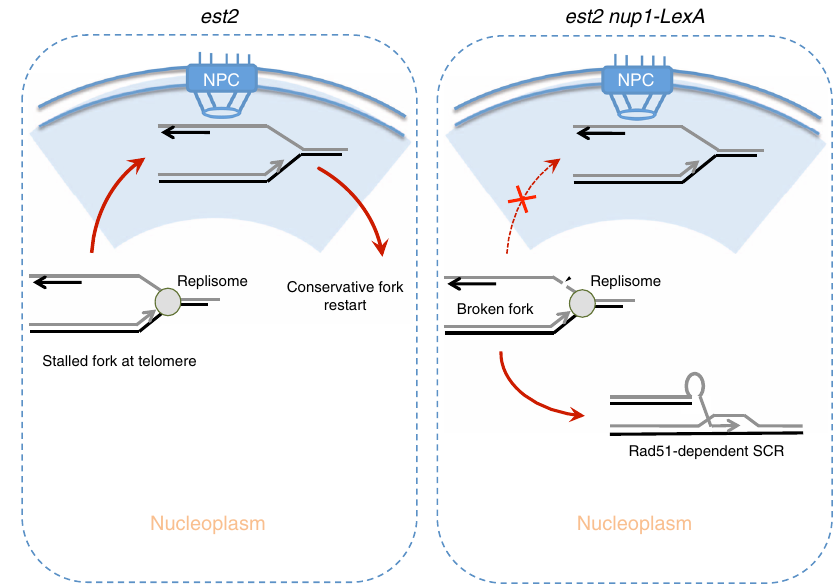
Fig. 8 Model for the role of the NPC in the repair of fork stalled at telomeres. Replication forks stalled at telomeres relocalize to the NPC and are mainly repaired by a conservative pathway that allows replication to resume (left). When this pathway fails, the stalled forks engage in error-prone Rad51- dependent SCR that maintain a telomere length compatible with continuous